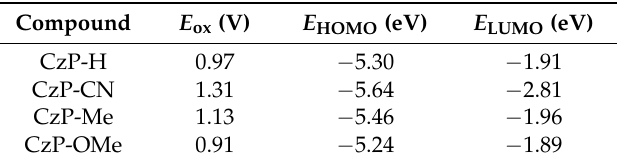
Figure S1: 1 H NMR spectrum of CzP-H; Figure S2: 1 H NMR spectrum of CzP-CN; Figure S3: 1 H NMR spectrum of CzP-Me; Figure S4: 1 H NMR spectrum of CzP-OMe; Figure S5: 13 C NMR spectrum of CzP-H; Figure S6: 13 C NMR spectrum of CzP-Me; Figure S7: 13 C NMR spectrum of CzP-OMe; Figure S8: HR-MS spectrum of CzP-H; Figure S9: HR-MS spectrum of CzP-CN; Figure S10: HR-MS spectrum of CzP-Me; Figure S11: HR-MS spectrum of CzP-OMe; Figure S12: Normalized absorption spectra and normalized PL